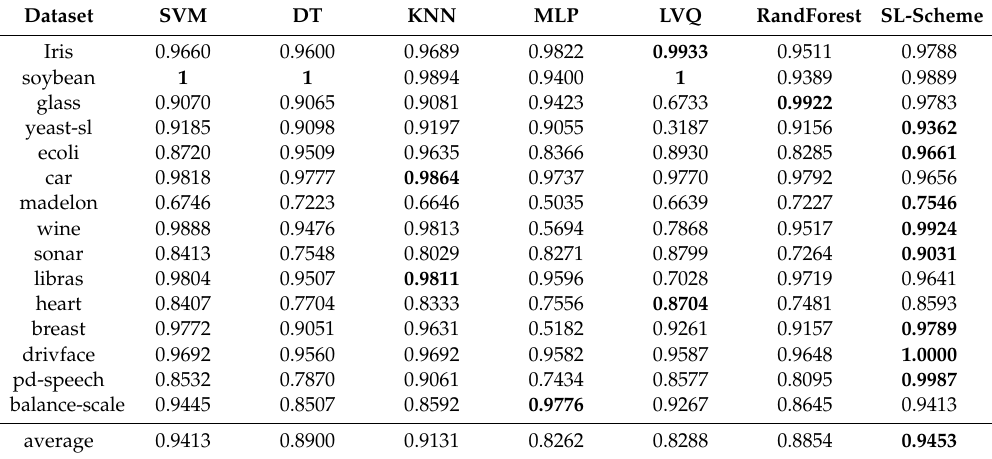
Table 2. Testing accuracy (ACC) obtained by di ff erent